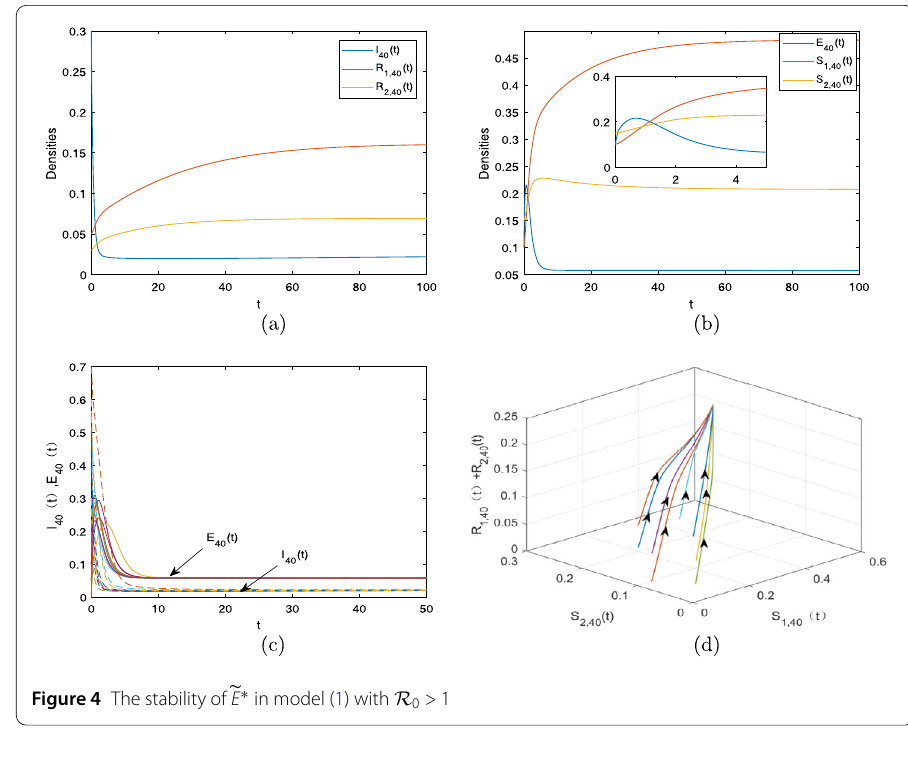
Figure 4 The stability of (cid:18) E ∗ in model (1) with R 0 > 1